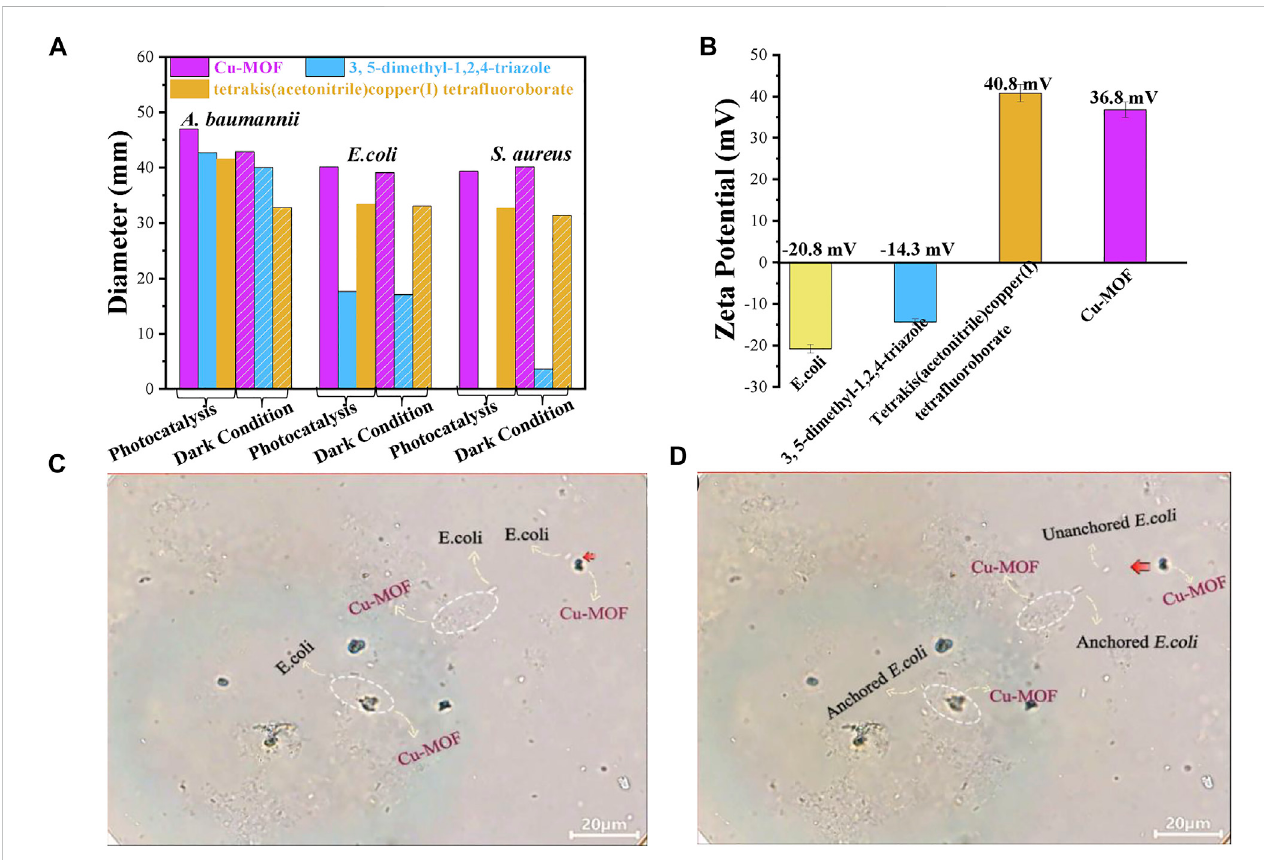
FIGURE 6 (A) TheuniversalapplicabilitytestingofantimicrobialsaroundCu-MOFs for S.aureus , A.baumannii, and E.coli underphotocatalysisanddarkconditions, respectively. (B) Zeta potential of E. coli suspension and different samples. The screenshots from an optical microscope for (C) unanchoredand (D) anchored E. coli